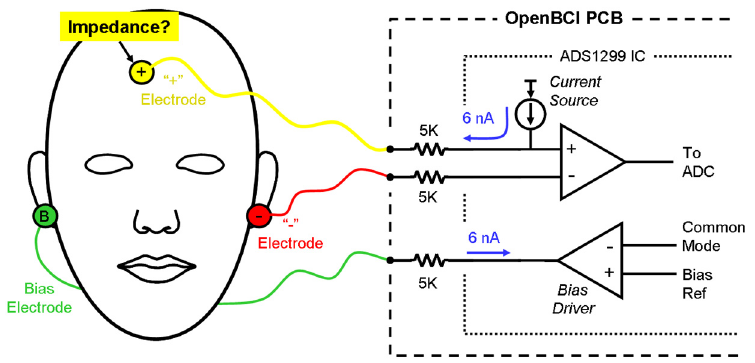
Figure 10. Skin-to-electrode impedance measurement using an OpenBCI system that possesses an ADS1299 to measure